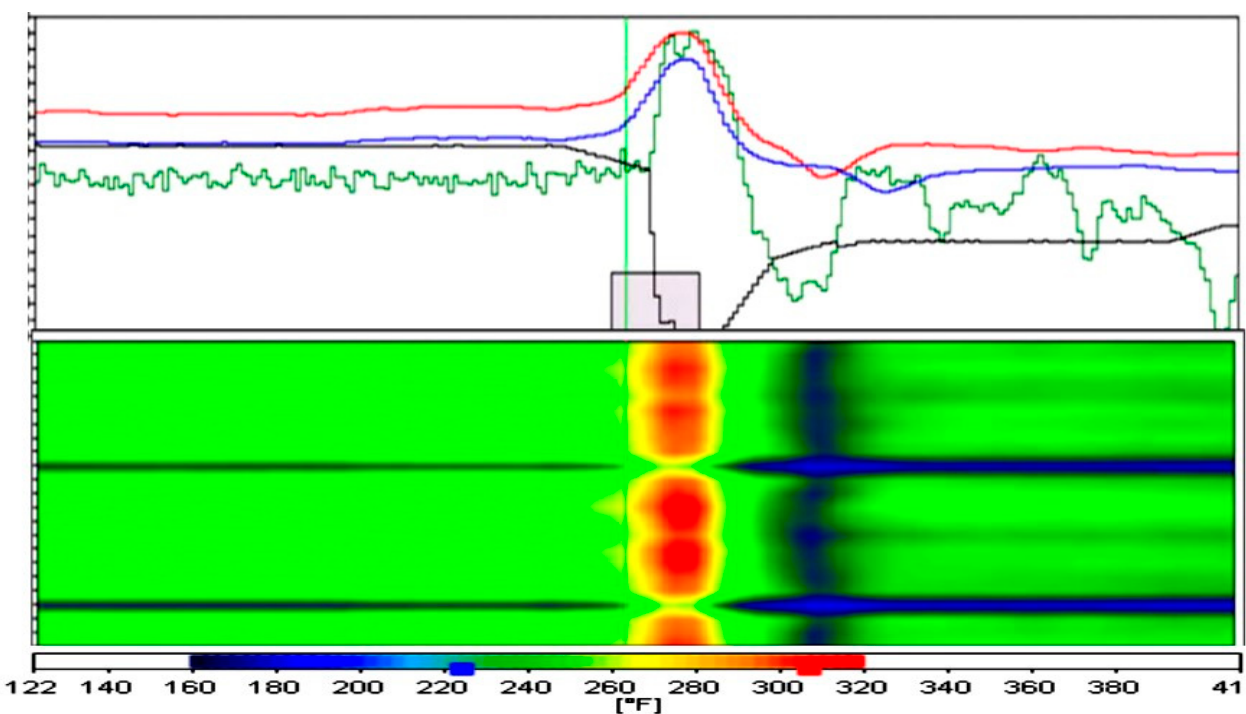
Figure 10. Alarms during stable casting conditions with temperature spectrum.